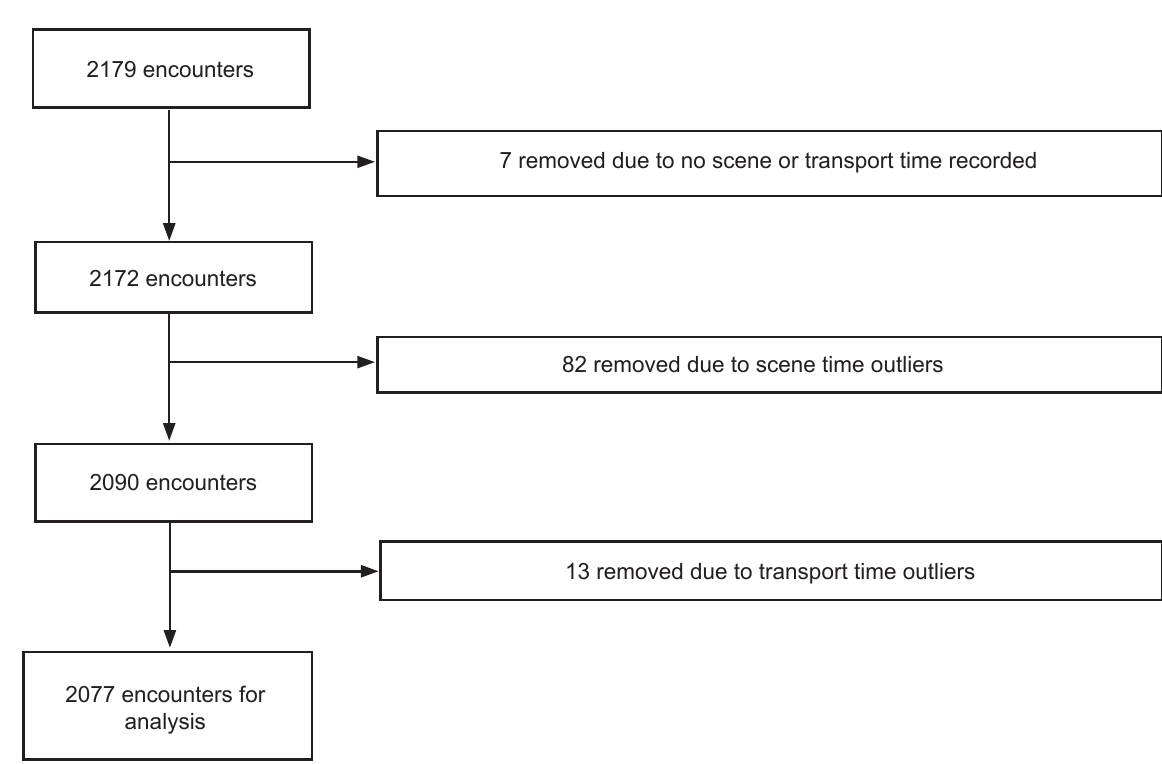
Figure 1. Case selection flow